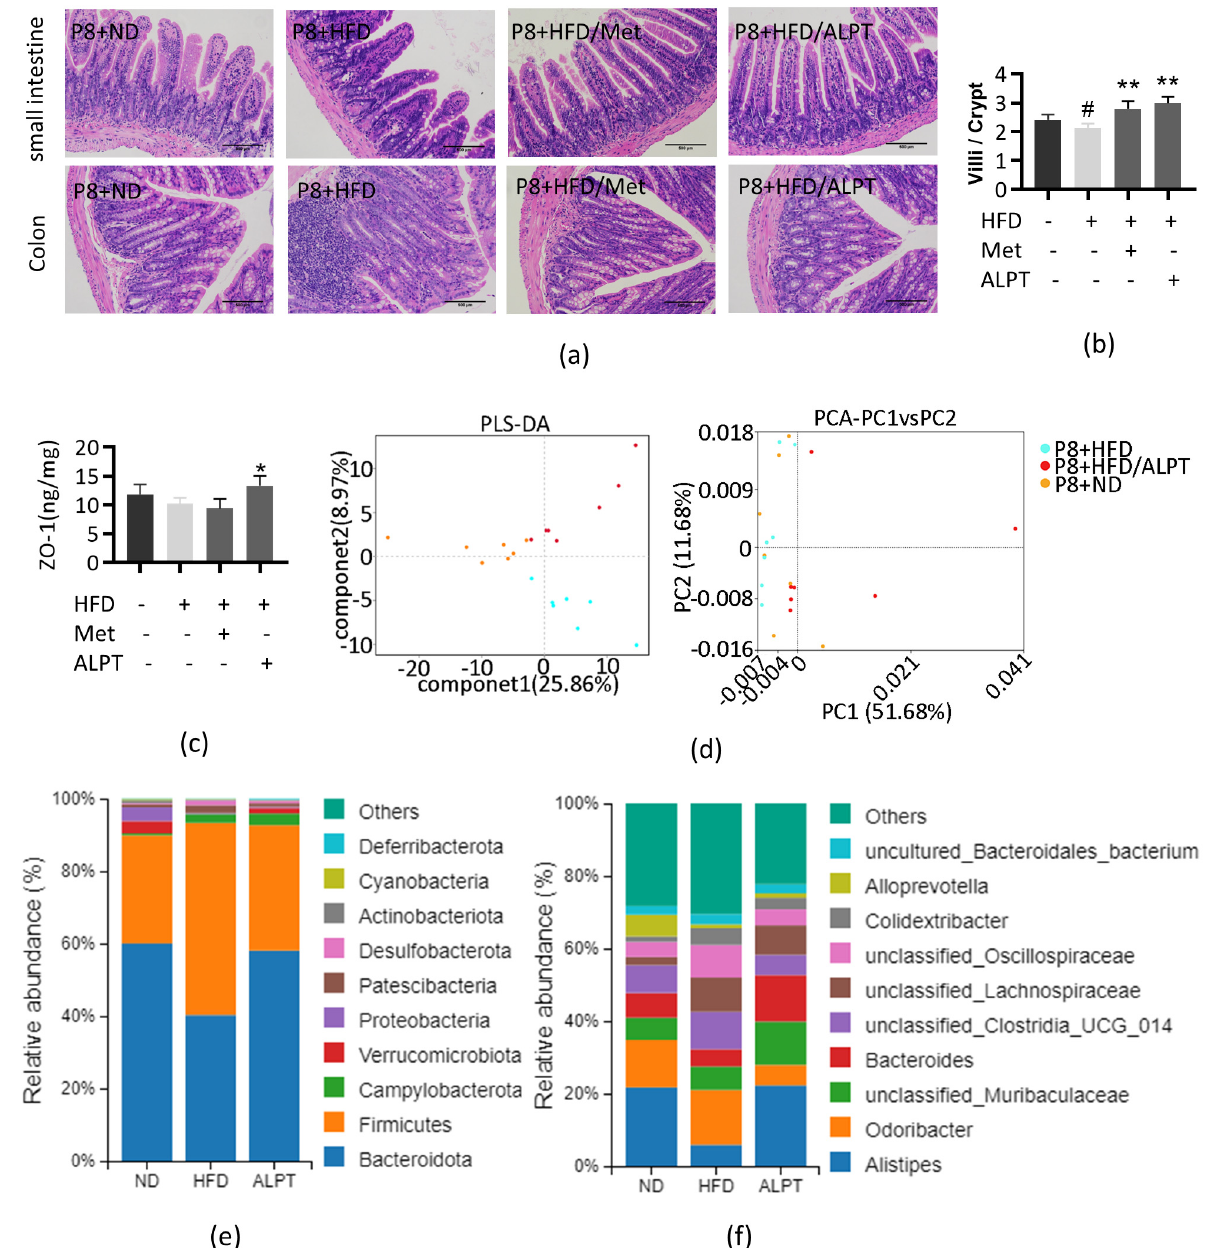
Figure 5. Analysis of intestinal structure and intestinal flora composition of mice in different groups.